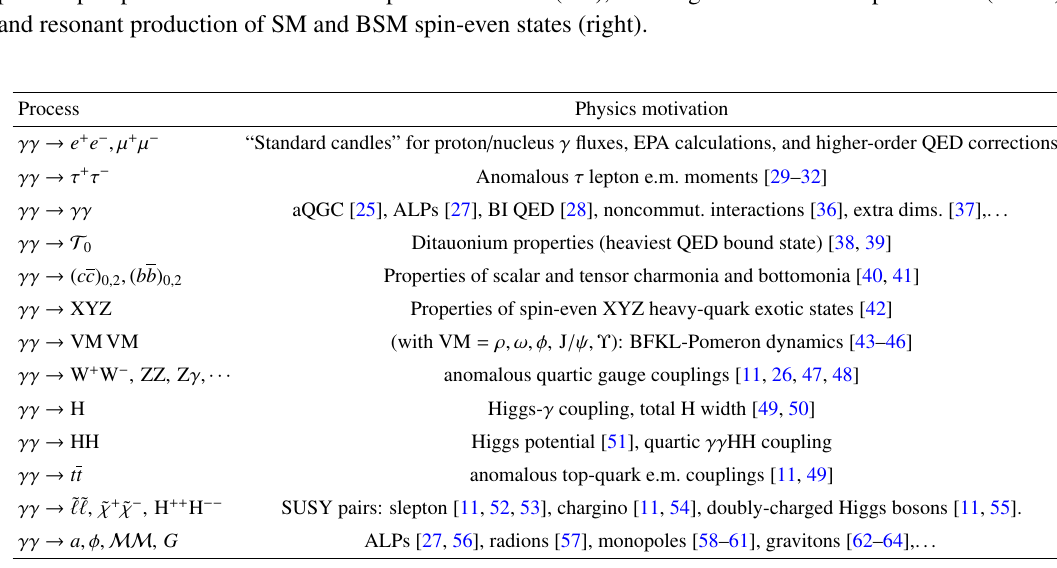
Table 1 . Gold-plated SM and BSM processes accessible via photon-photon collisions in UPCs at hadron